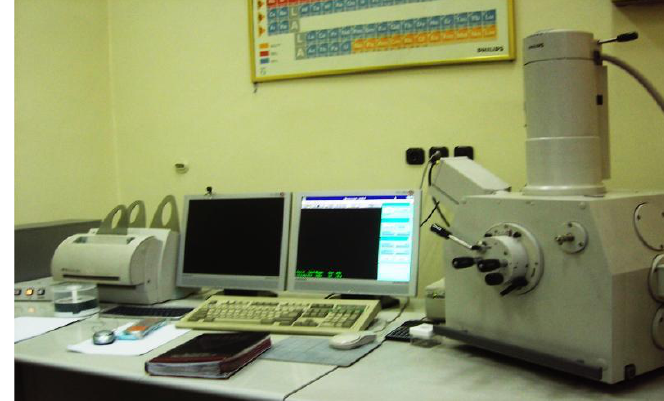
Fig. 1. SEM unit Figure 1. SEM unit